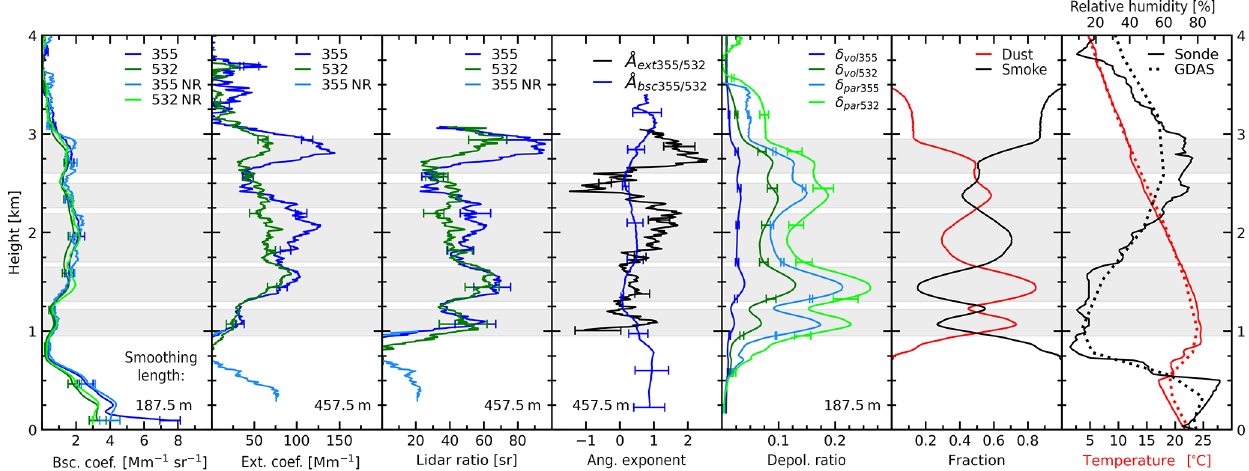
Figure 11. Averaged profiles for 29 April 2016, 20:15–21:00UTC. Dust and smoke fractions calculated following Tesche et al. (2009). Meteorological data from GDAS1 (29 April 2016, 21:00UTC) and radio sounding measurements (29 April 2016, 15:00UTC). Layers are marked grey.